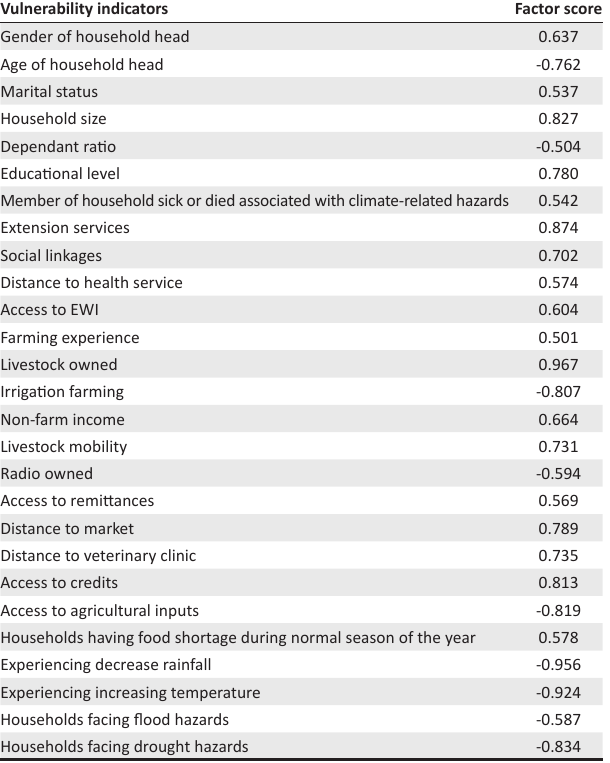
TABLE 4: Factor loadings of vulnerability indicators from principal component analysis. Vulnerability indicators